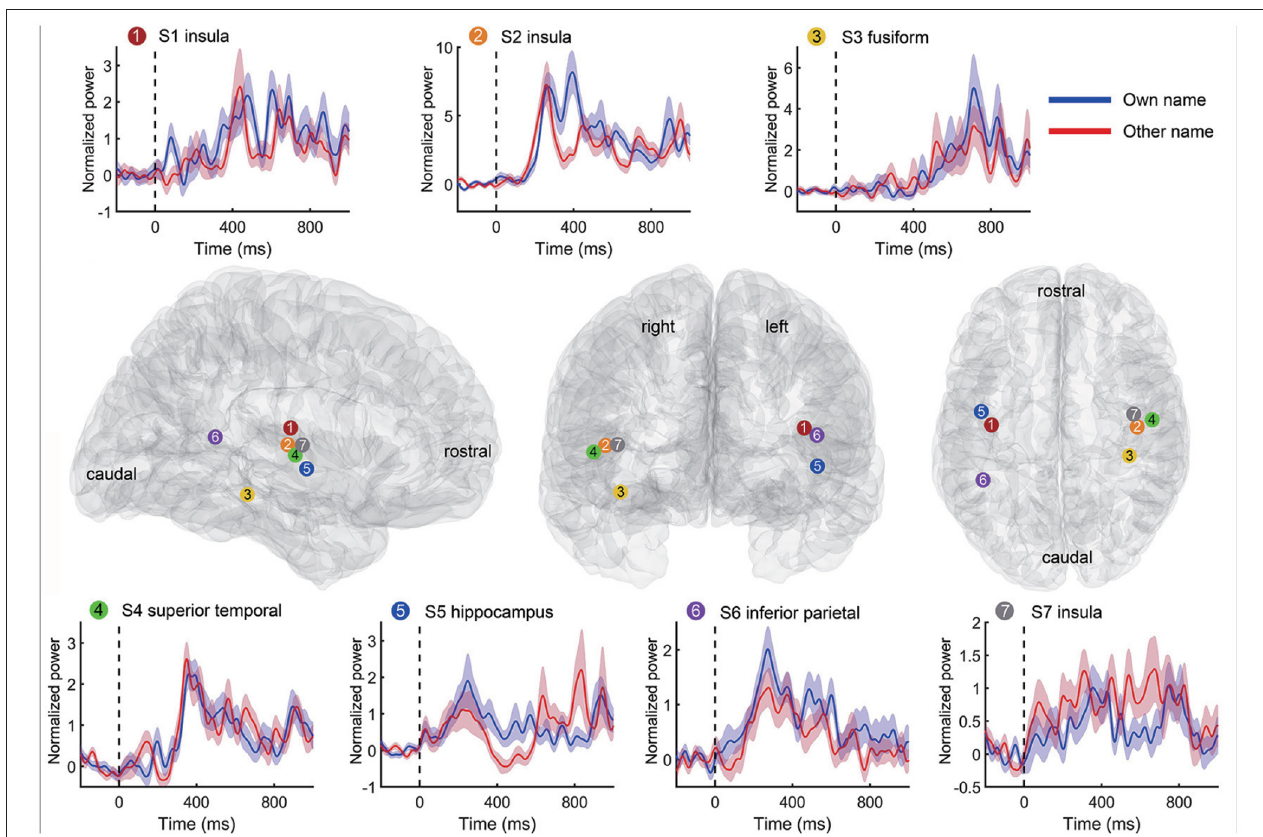
FIGURE 3 | Representative high-gamma responses and positions of active channels for each subject. Each time-power plot in the top and bottom rows reflects a subject’s high-gamma power (mean and standard error) across trials from an active channel. The responses to own name and other’s name stimuli were displayed separately. The black vertical line indicates the stimuli onset. The standard Montreal Neurological Institute (MNI) brain models in the middle row show positions of the above channels in the sagittal, coronal, and transverse view. Channel positions of different subjects are marked with different colors and